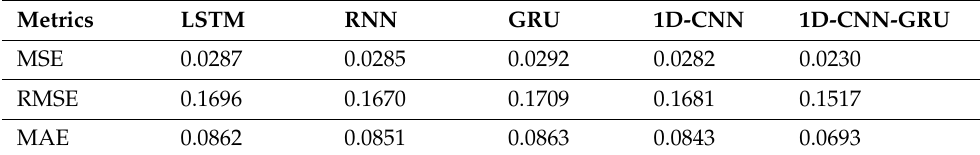
Table 4. Performance Evaluation of LSTM, RNN, GRU, 1D-CNN, and 1D-CNN-GRU.